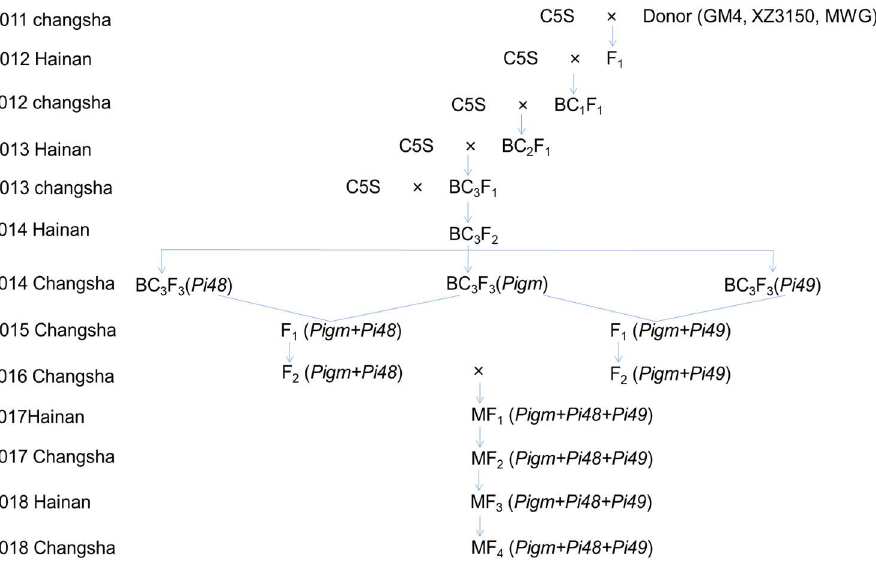
Figure 1. Breeding scheme for developing introgression lines of C5S carrying rice blast resistance genes Pigm , Pi48 and Pi49